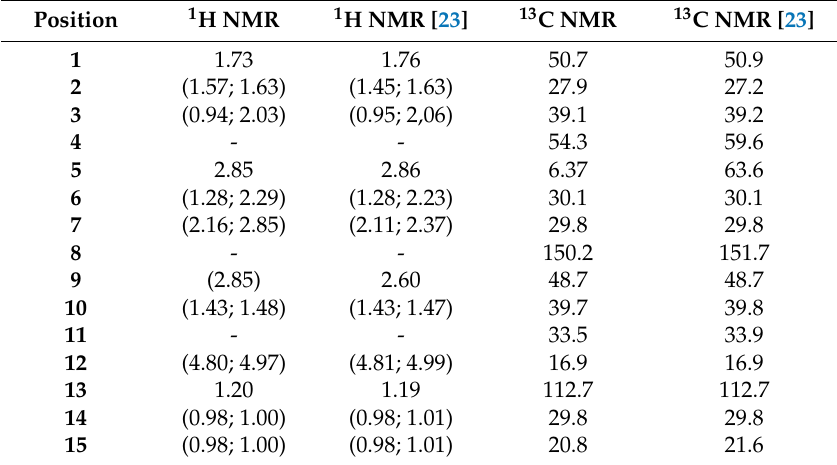
Table 9. NMR data of Caryophyllene oxide (S 39) compared to literature data. Position